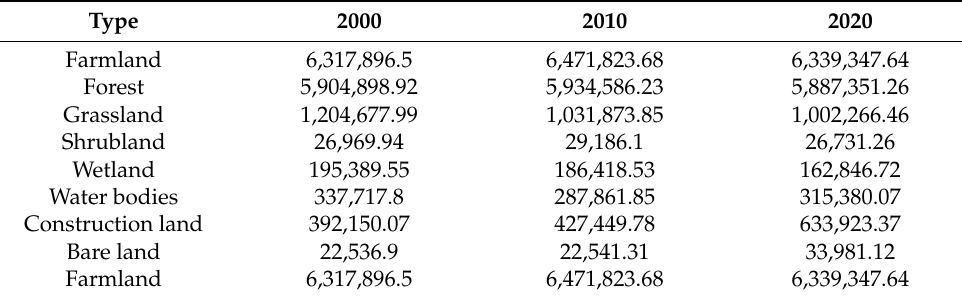
Table 2. Land-use status of the study area in 2000, 2010, and 2020 (hm 2